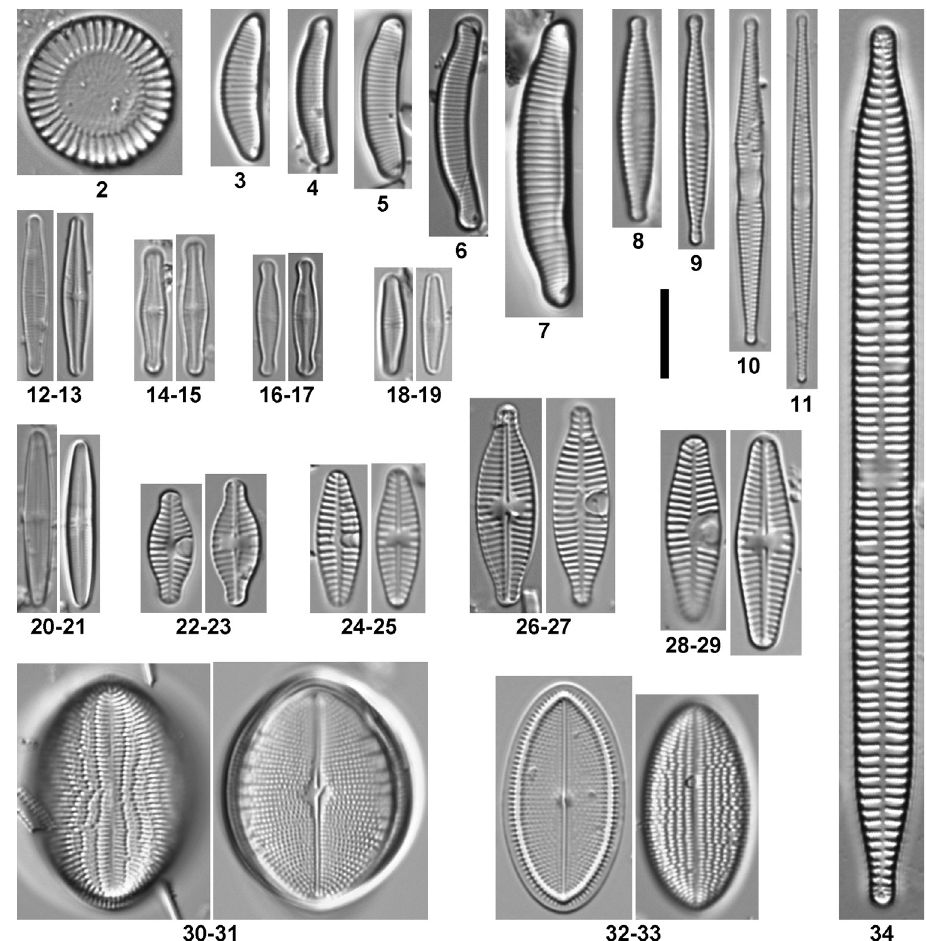
Figures 2–34. Overview of the most abundant taxa (≥ 1% relative abundance in at least one sample). 2 Cyclotella meneghiniana 3 Eunotia cf. meridiana 4 Eunotia sp. 1 5 Eunotia sp. 3 6 Eunotia sp. 2 7